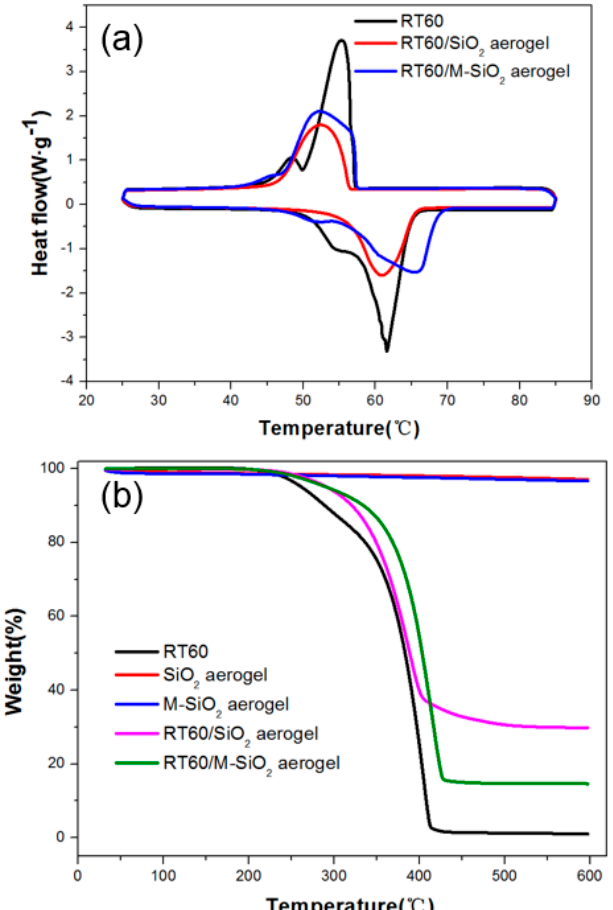
Figure 7. DSC curves of RT60, RT60/SiO 2 , RT60/M-SiO 2 aerogels at a heating rate of 10 °C·min − 1 ( a ), thermal stability measurements of SiO 2 aerogel, M-SiO 2 , RT60, RT60/SiO 2 , RT60/M-SiO 2 aerogels at 10 °C·min − 1 ( b ).